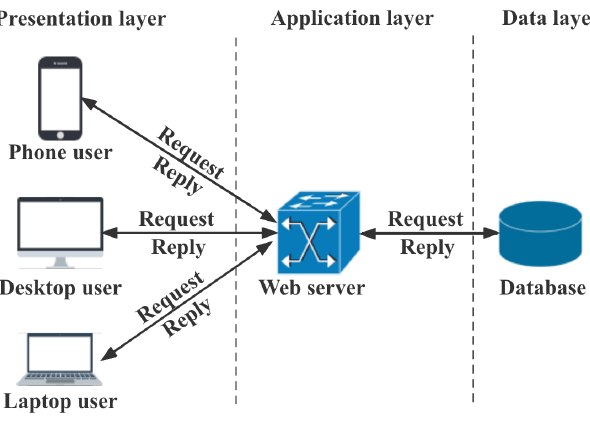
Figure 4. Logical structure of the risk assessment